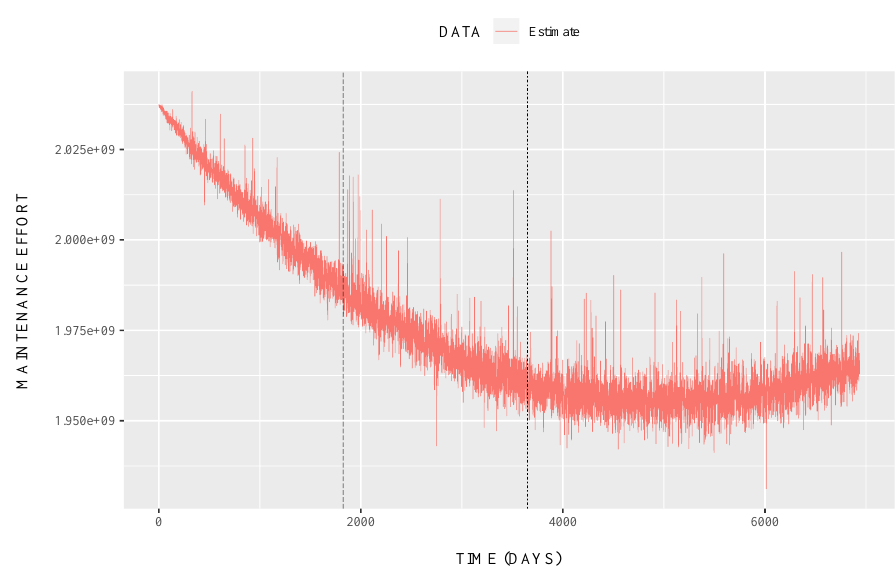
Figure 4. The sample path of estimated total OSS effort for exponential type